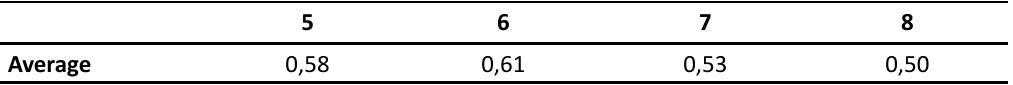
Table 3: The Average SITC 5-8 between Indonesia and Trading Partner Countries 5 6